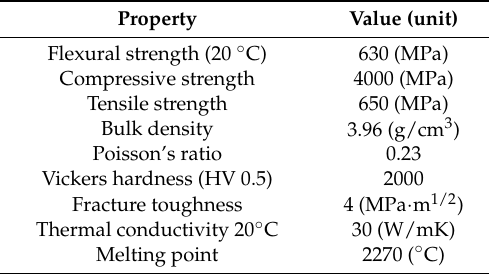
Table 1. Mechanical and thermal properties of alumina materials